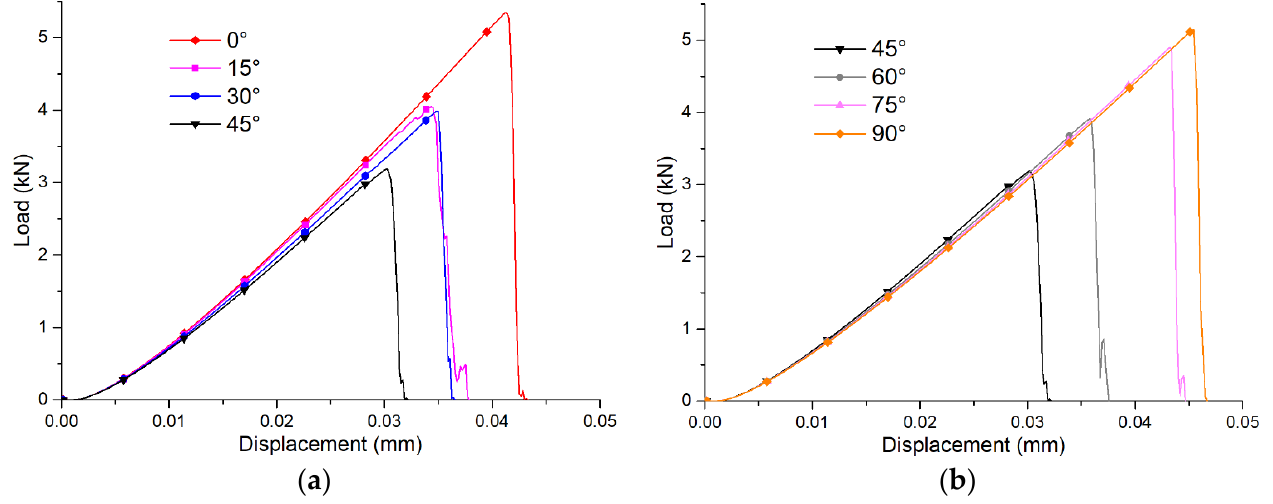
Figure 2. Load – displacement curves for the Brazilian discs with cracks of different angles. ( a ) The crack angle is between 0 ◦ and 45 ◦ ; ( b ) crack angle is between 45 ◦ and 90 ◦ . The peak load and peak displacement of the Brazilian disc with the 0 ◦ crack are 5.34 kN and 0.041 mm, respectively. The peak load and peak displacement of the Brazilian disc with the 45 ◦ crack are 3.19 kN and 0.030 mm, respectively. The peak load and peak displacement of the Brazilian disc with the 90 ◦ crack are 5.15 kN and 0.045 mm, respectively. The Brazilian disc with the 0 ◦ crack has the largest peak load, the Brazilian disc with the 90 ◦ crack has the largest peak displacement, and the Brazilian disc with the 45 ◦ crack has the smallest peak load and peak